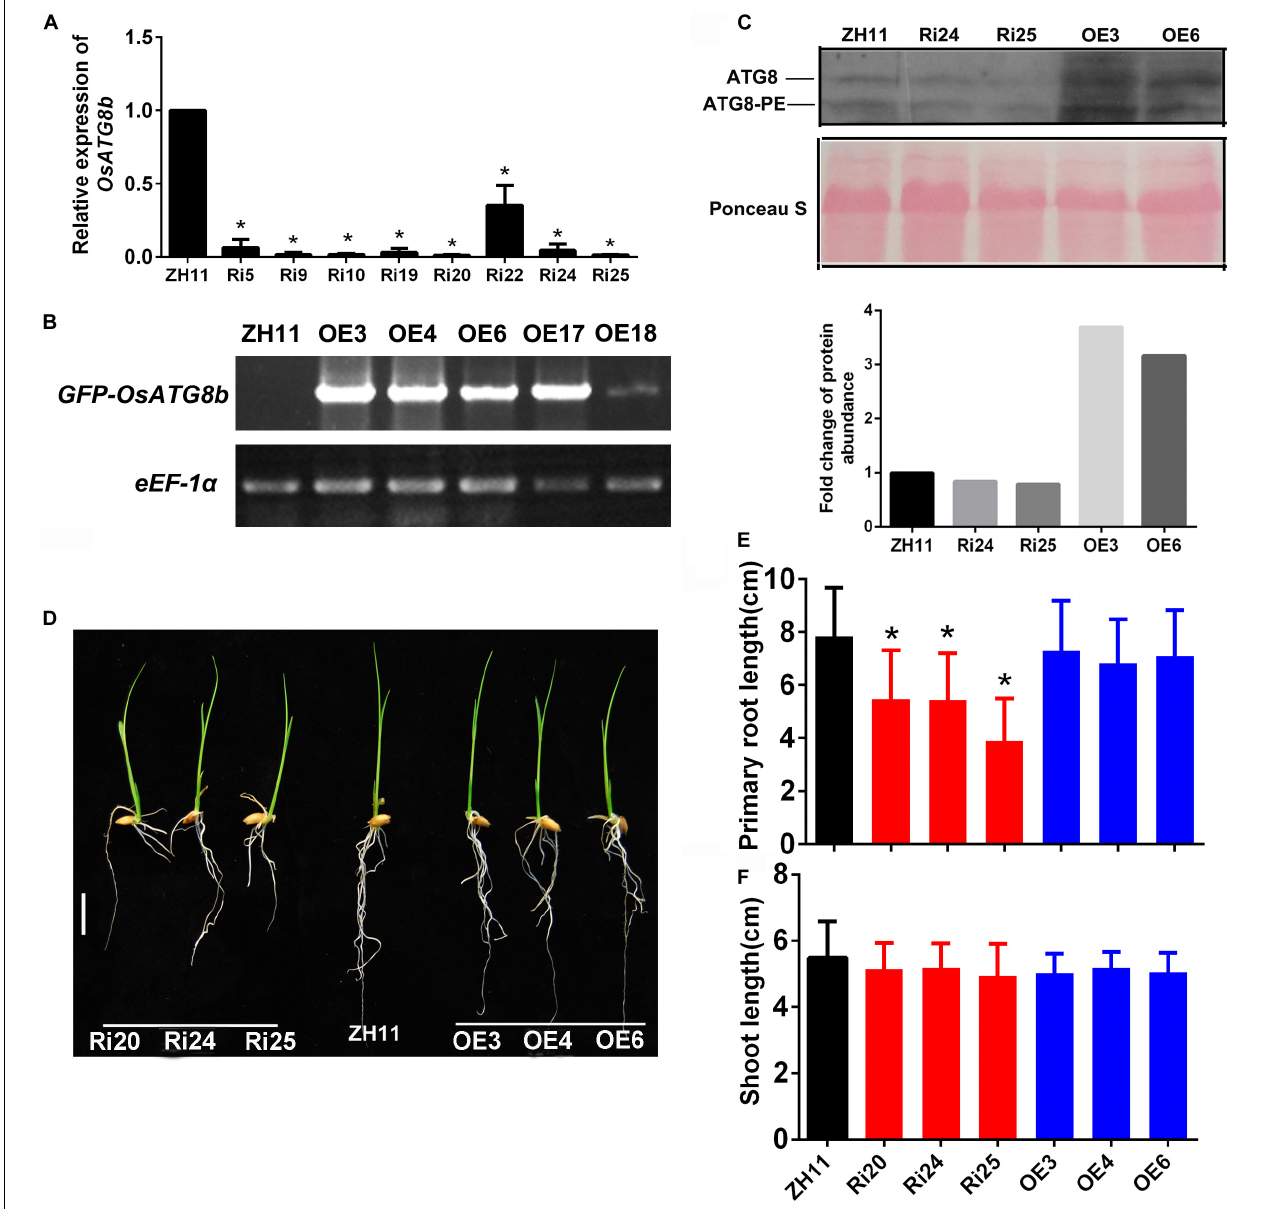
FIGURE 4 | OsATG8b affects root growth at seed germination stage. (A,B) Expression levels of OsATG8b in flag leaves of OsATG8b -RNAi (Ri) (A) and OsATG8b -overexpression (OE) lines (B) , measured by qRT-PCR and semi-qRT-PCR analyses, respectively. OseEF-1a was used as an internal reference. Error bars indicate standard deviations of independent biological replicates ( n = 3). One asterisk (* p < 0.05, t -test) represents significant difference. (C) Immunoblot detection of the OsATG8a/b/c and OsATG8a/b/c lipidation level in 14 days-after-germination shoots of ZH11, OsATG8b -RNAi, and OsATG8b -OE lines. Total protein extracts were subjected to SDS-PAGE in the presence of 6M urea and immunoblotted with OsATG8b antibody. The fold change of ATG8a/b/c-PE was quantified using Image J software v1.45. (D–F) Seedlings (D) and statistical analysis of root (E) and shoot length (F) of OsATG8b -RNAi and OsATG8b -OE lines and ZH11 at 7-day after germination in water. Bar = 1 cm. Three biological replicates, each containing 80 plants, were used for data analysis. Results are the mean ± SD from 80 plants. * p < 0.05 ( t -test): significantly different from ZH11. No asterisks mean no significant difference.